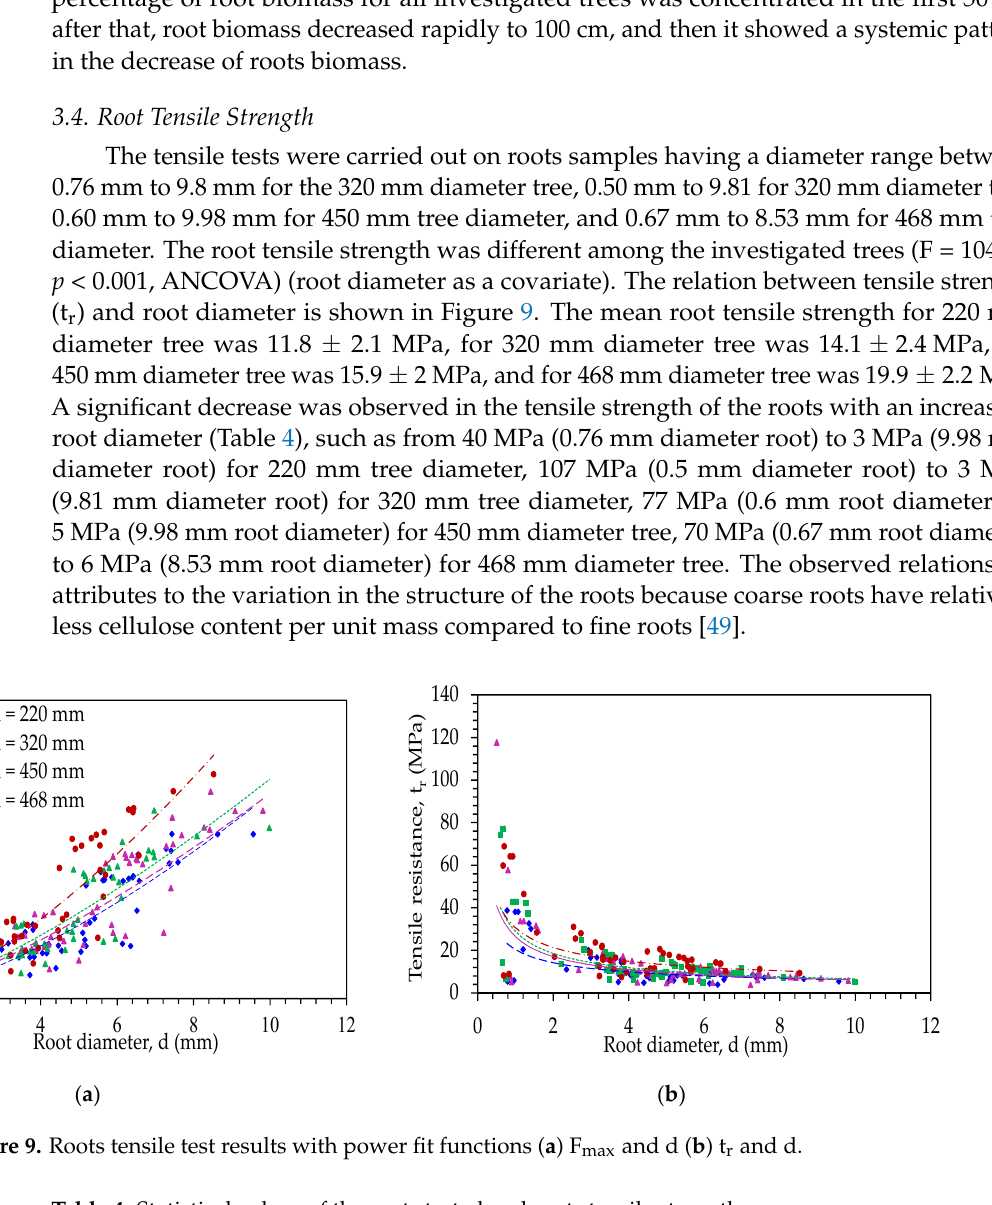
Figure 8. Variation of roots indices with lateral distance from the tree stem ( a ) RAR ( b ) RD, and ( c ) RB.